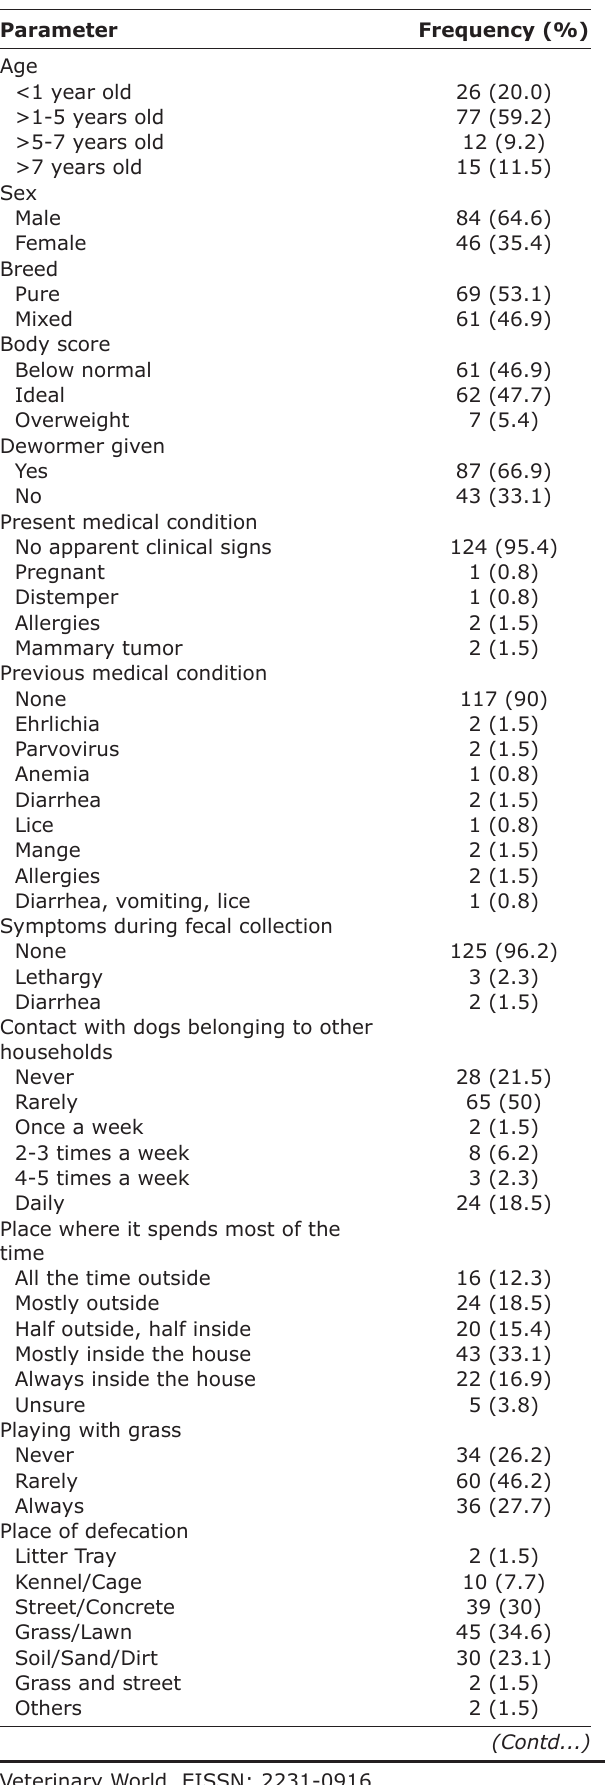
Table-1: Profile of household dogs and its selected rearing practices in Cebu, Philippines